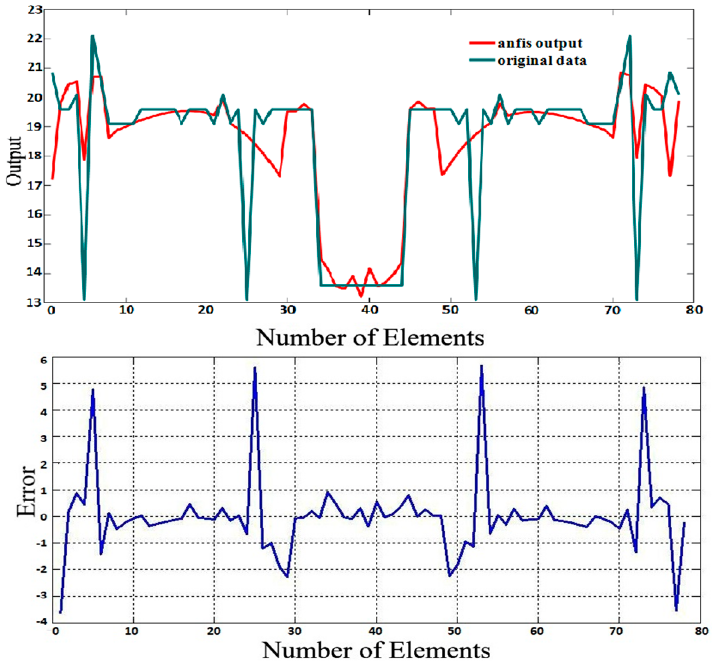
Figure 14. Original and fuzzy output with error function obtained from curve fitting method.